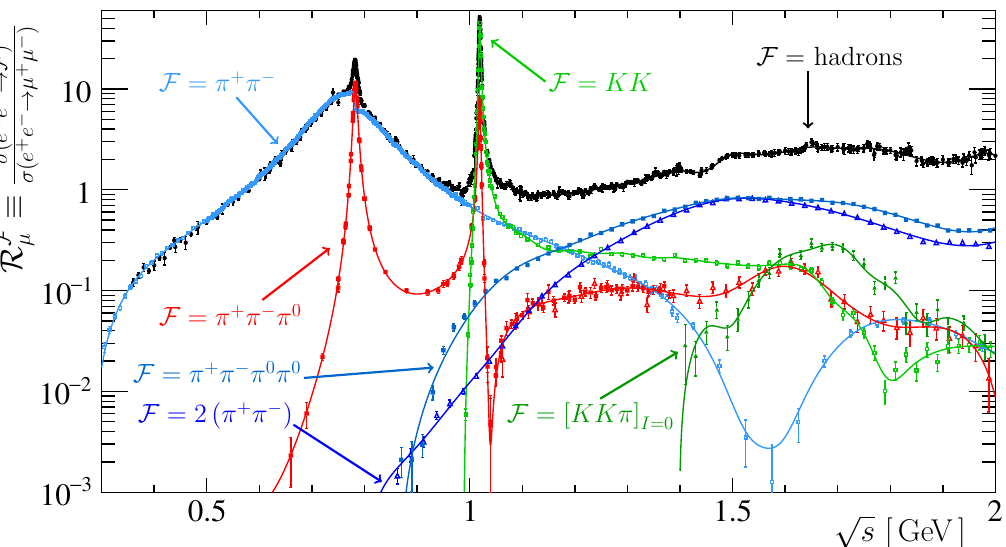
Figure 1 . Data used to determine the hadronic decay rates from: the PDG, for the total rate to hadrons [78]; BaBar, for (cid:25) + (cid:25) (cid:0) [79], high-mass (cid:25) + (cid:25) (cid:0) (cid:25) 0 [80] (displayed as open